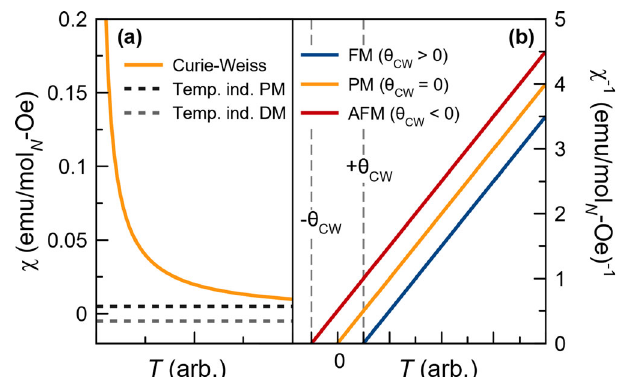
Fig. 1 Appearance of Curie – Weiss behavior in direct and inverse susceptibility. a Curie – Weiss susceptibility due to paramagnetic local moments goes as 1/ T and is typically at least an order of magnitude larger than than other temperature independent contributions to susceptibility such as Pauli or van Vleck paramagnetism (PM), or orbital and Landau diamagnetism (DM). b The inverse susceptibility of a material that follows the Curie – Weiss law will be linear in temperature and the x − intercept gives the Curie – Weiss temperature ( θ CW ) with positive values indicating net ferromagnetic (FM) interactions, negative values indicating antiferromagnetic (AFM) interactions, and values close to zero indicating negligible